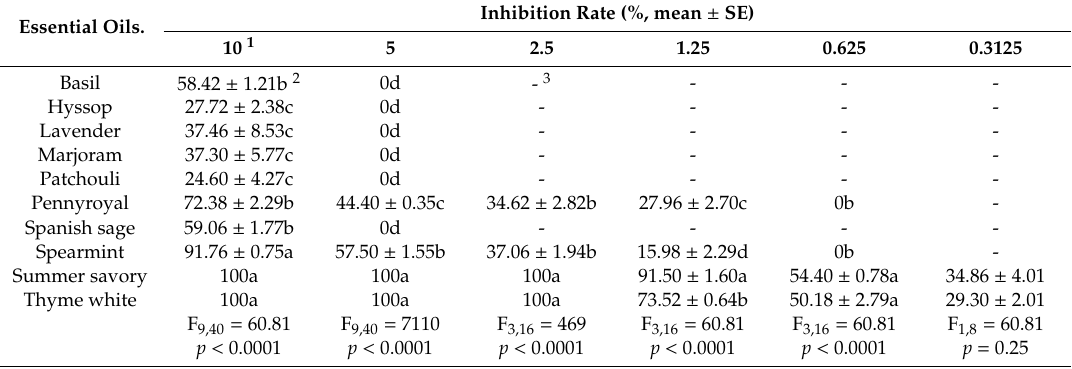
Table 2. Fumigant antifungal activities of Lamiaceae plant essential oils against R. quercus-mongolicae . Essential Oils.